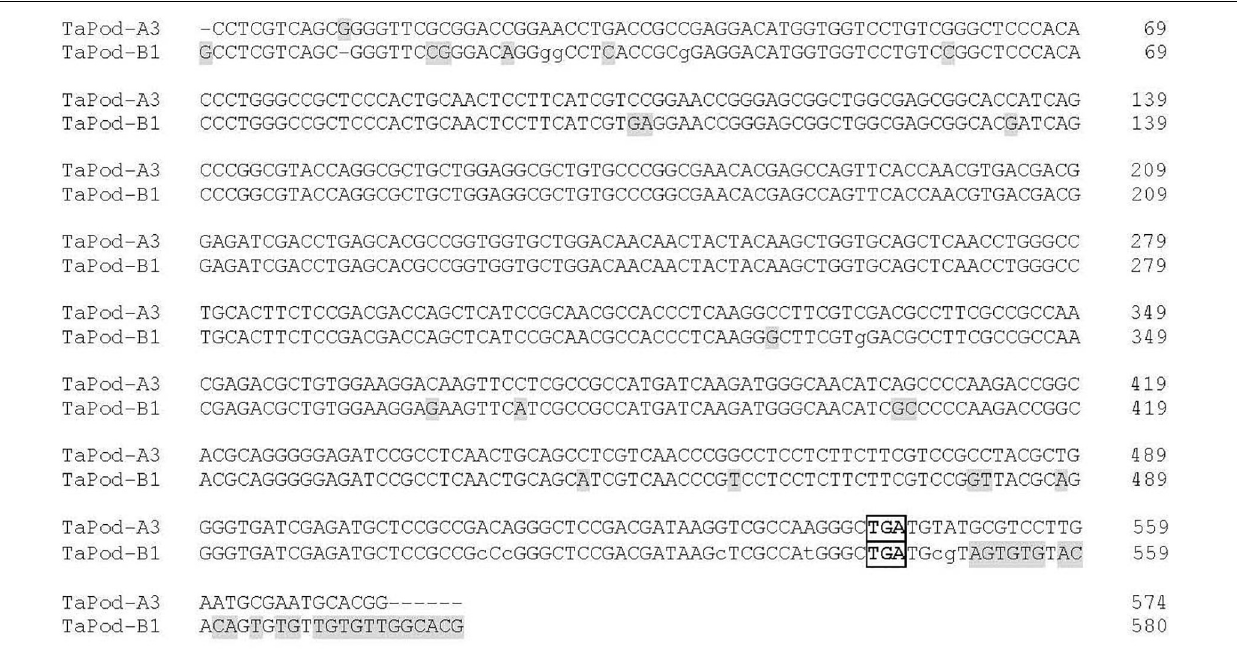
FIGURE 3 | Alignment of TaPod-A3 and TaPod-B1 . The SNPs are shaded . The terminate codons are boxed. Hyphens indicate gaps to improve the alignment.